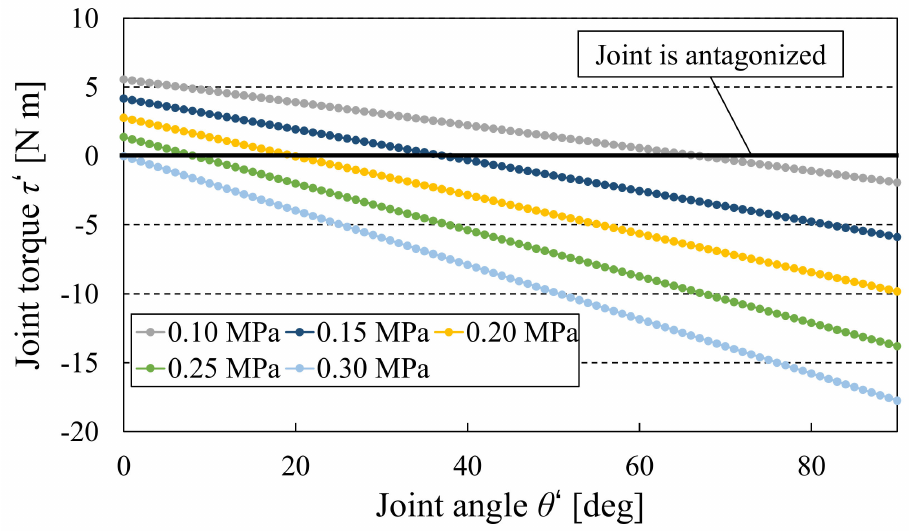
Figure 4. Relationship between the joint torque and the joint angle of the one-sided spring antago- nized joint